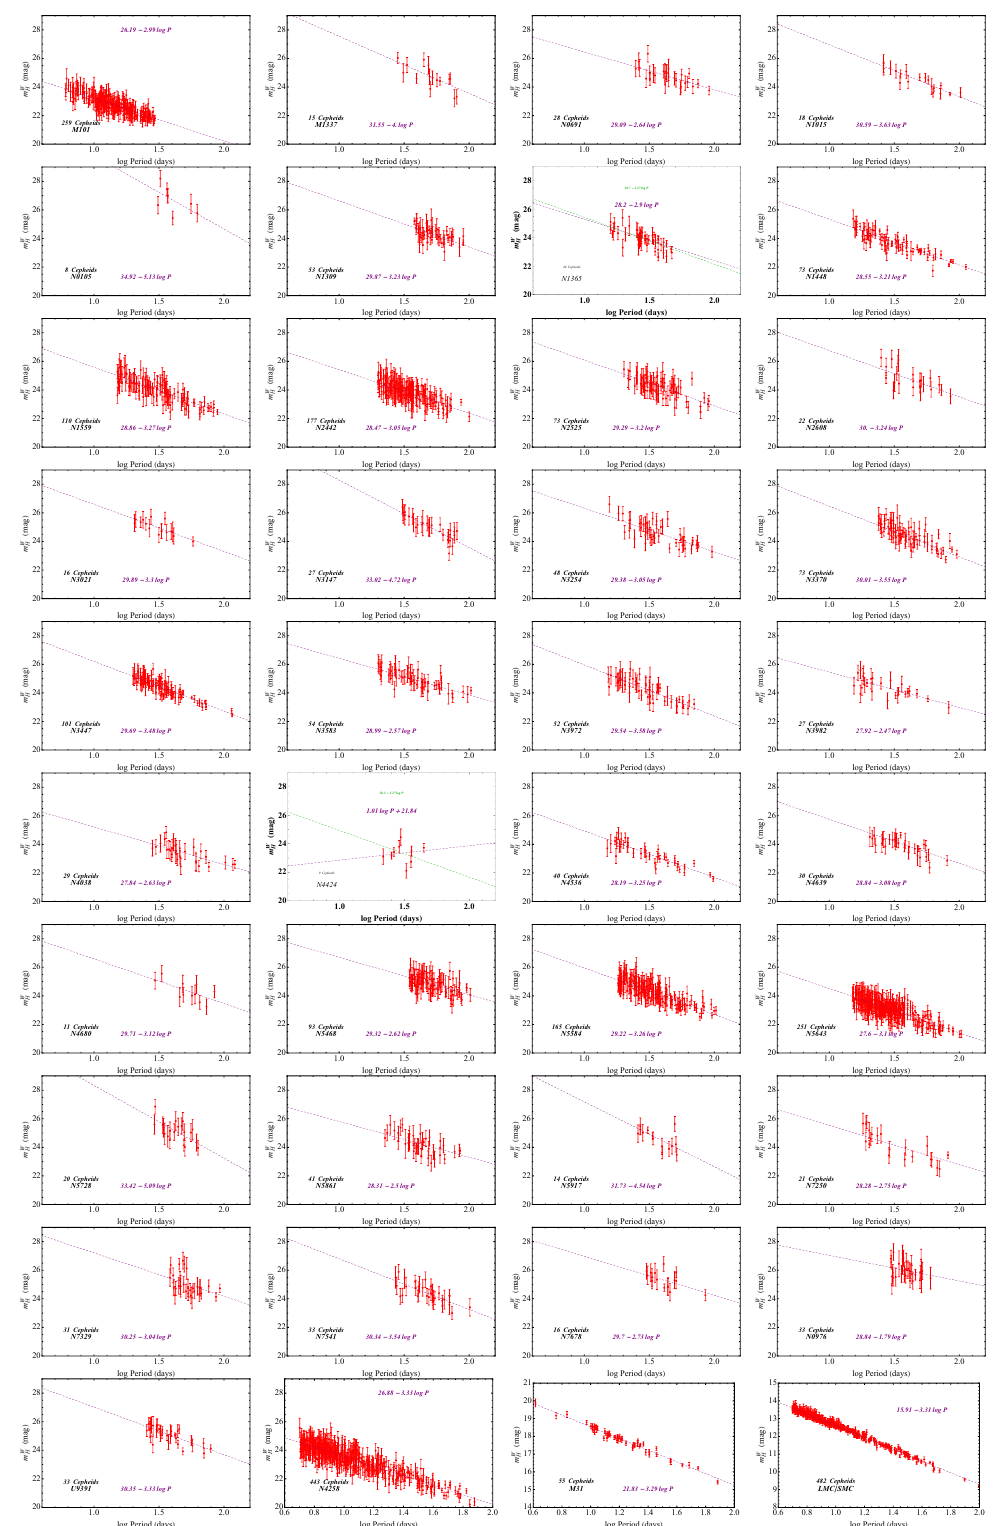
− log P , P-L relations for 40 Cepheid hosts: 37 Figure A2. Fitting individual slopes b W of the m W H SnIa+Cepheid hosts, 2 anchors (N4258+LMC/SMC) and the pure Cepheid host M31. In the case of the SnIa+Cepheid host N4424, our fit (purple line) is not in agreement with the fit of R21 (green line). In all other cases, the agreement is very